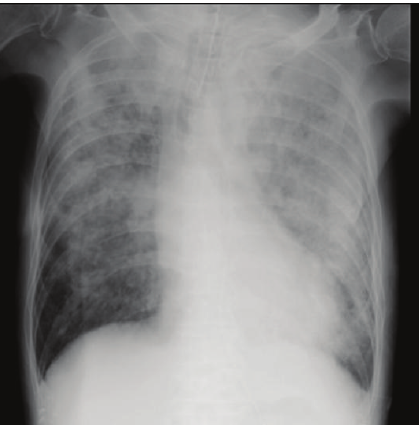
Figure 1: A chest radiograph on admission to the intensive care unit showed diffuse bilateral infiltrates, consistent with pulmonary edema and hemorrhage.